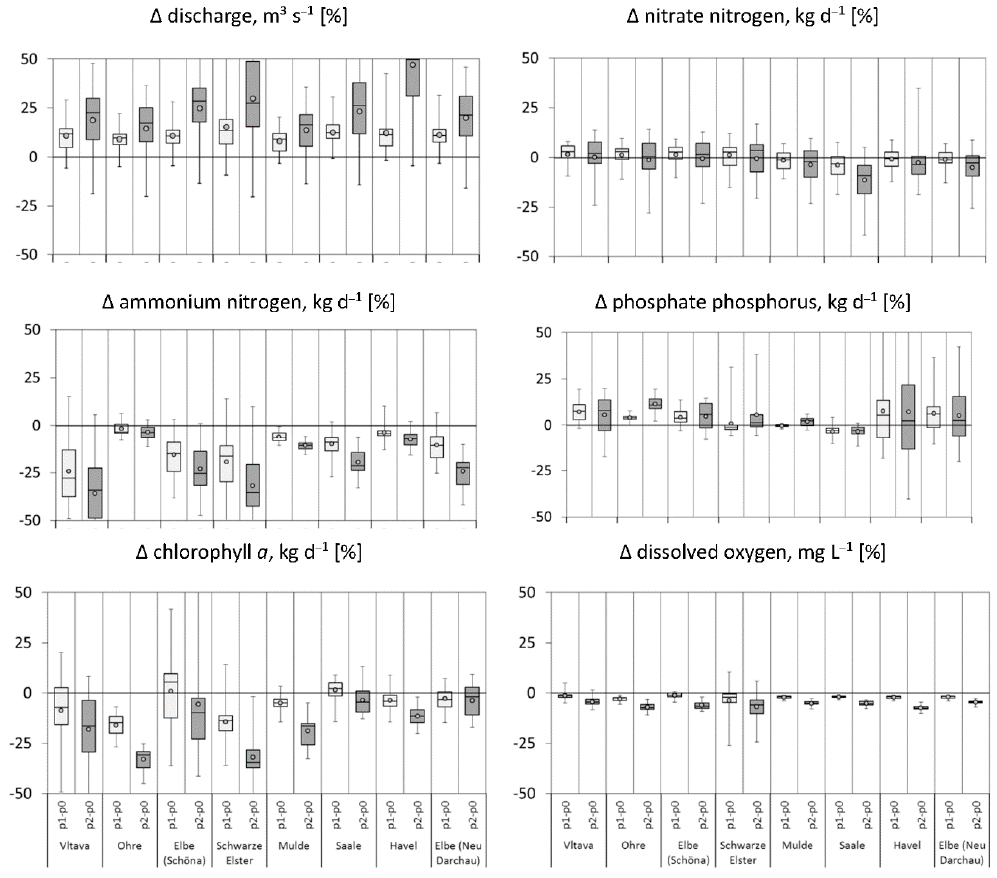
Figure 7. Ranges of the percental changes of 30-year-average river discharges, nutrients and chlorophyll a loads, as well as dissolved oxygen concentrations in the Elbe river and its main tributaries simulated with SWIM driven by 19 ENSEMBLES climate scenarios (in future periods p1 ( light ) and p2 ( dark ) compared to the reference period p0 of the same scenario). The plots visualize the following ranges: min/max ( whiskers ), 25th/75th percentiles ( boxes ), median ( line ) and average ( dots ) changes of all 19 scenarios.